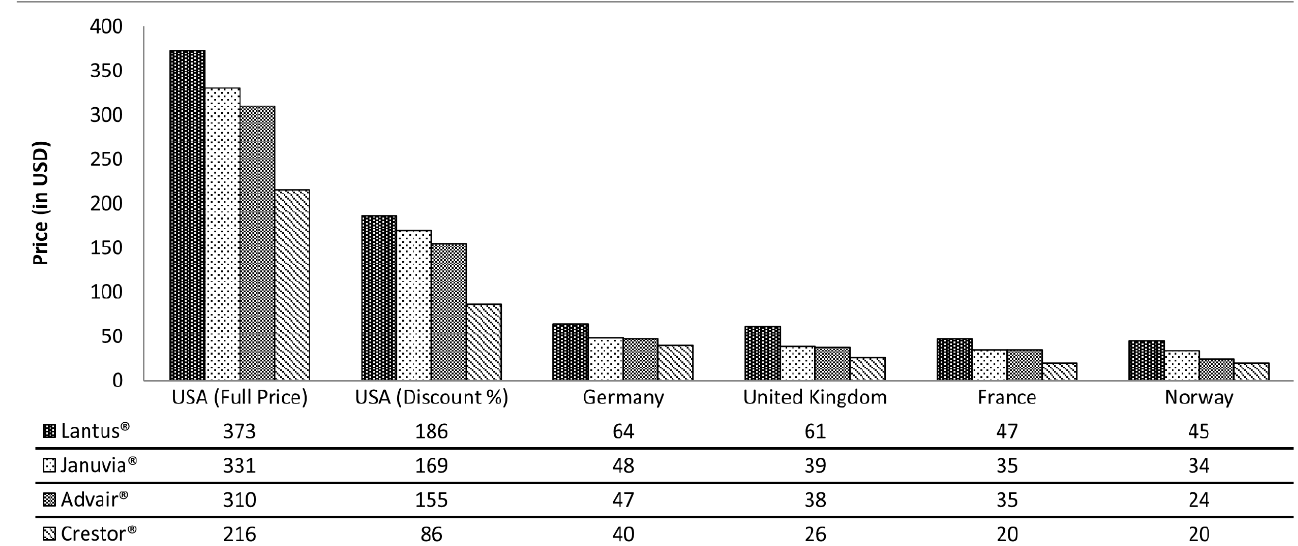
Figure 4. Regulatory flux for the approval of pharmaceutical products (abbreviations: NDA, new drug application; FDA, Food and Drug Administration; HHS, Department of Health and Human Services; CMS, Centers for Medicare & Medicaid Services; HMO, health maintenance organization; PBM, pharmacy benefit manager) [12].